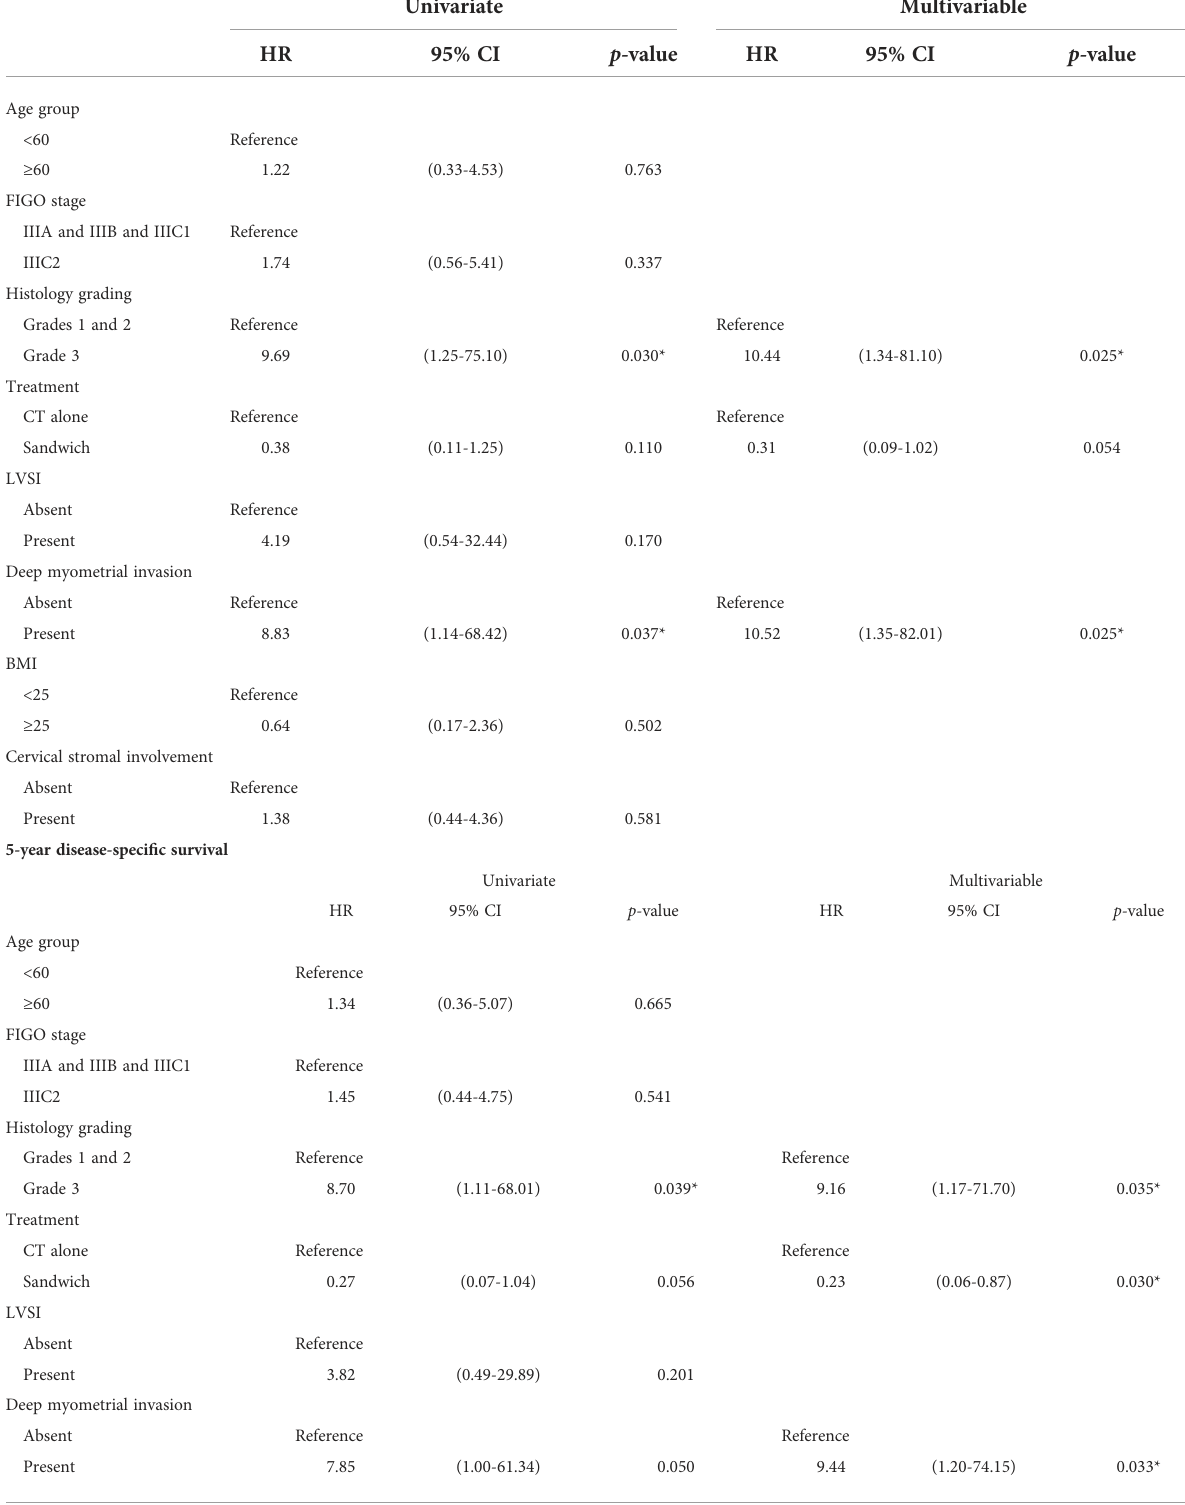
TABLE 2 Univariate and multivariable analyses of prognostic factors for 5-year OS, PFS, and